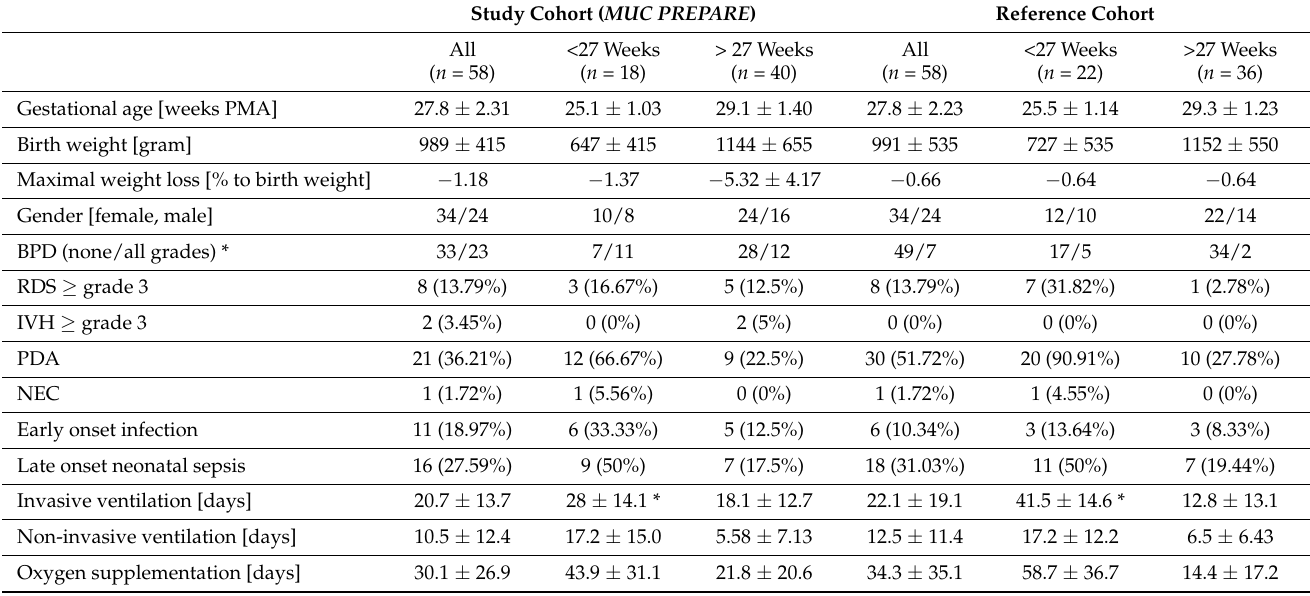
Table 1. Patient